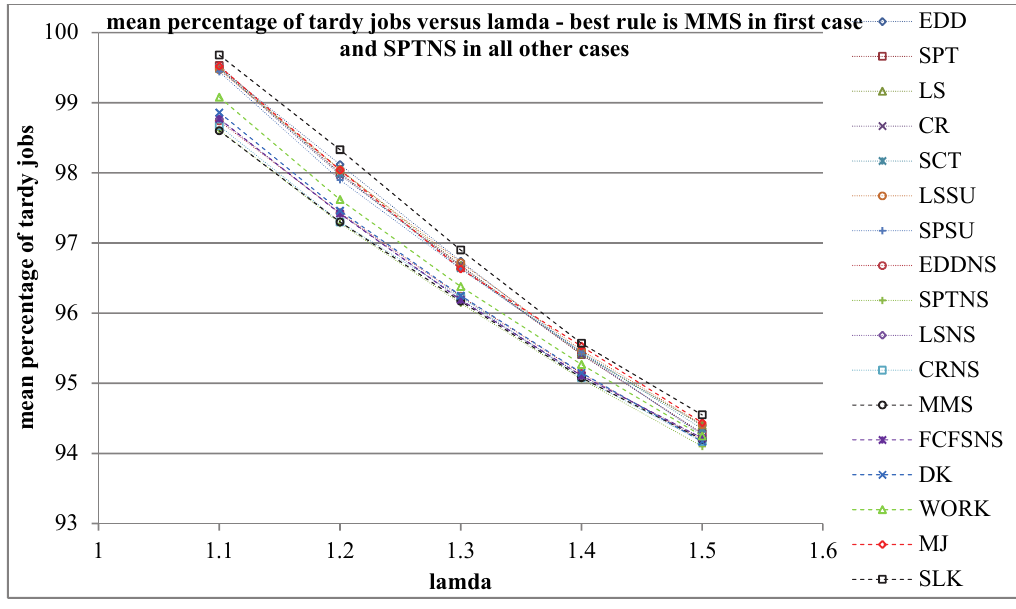
Fig. 4. Mean percentage of tardy jobs for simulation cases 1 – 5